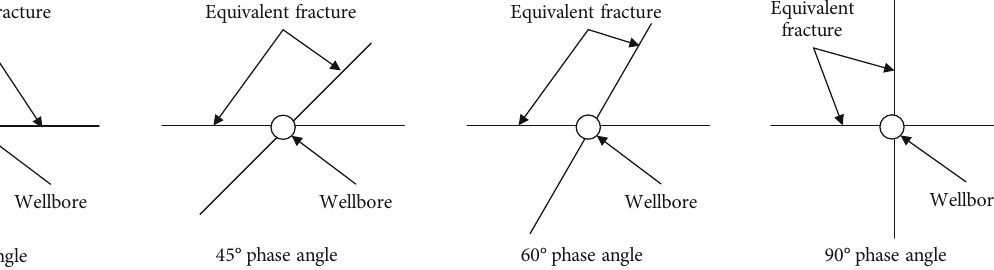
Figure 12: Relative curve of oil and water.